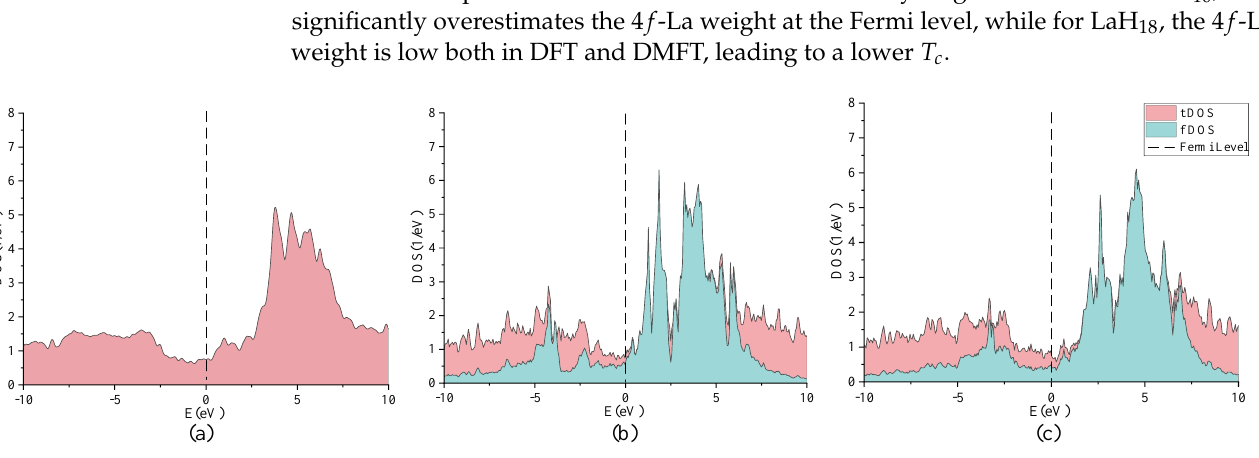
Figure 4. ( a ) Density of states produced by DFT calculations. In ( b , c ), we show the density of states, obtained within the one-shot DFT + DMFT and within the full-charge self-consistent DFT + DMFT + CSC, respectively. tDOS and f DOS signify the density of states corresponding to the lattice and f impurity Green’s function, respectively. All calculations were carried out in the Fmmm phase of LaH 18 at 400